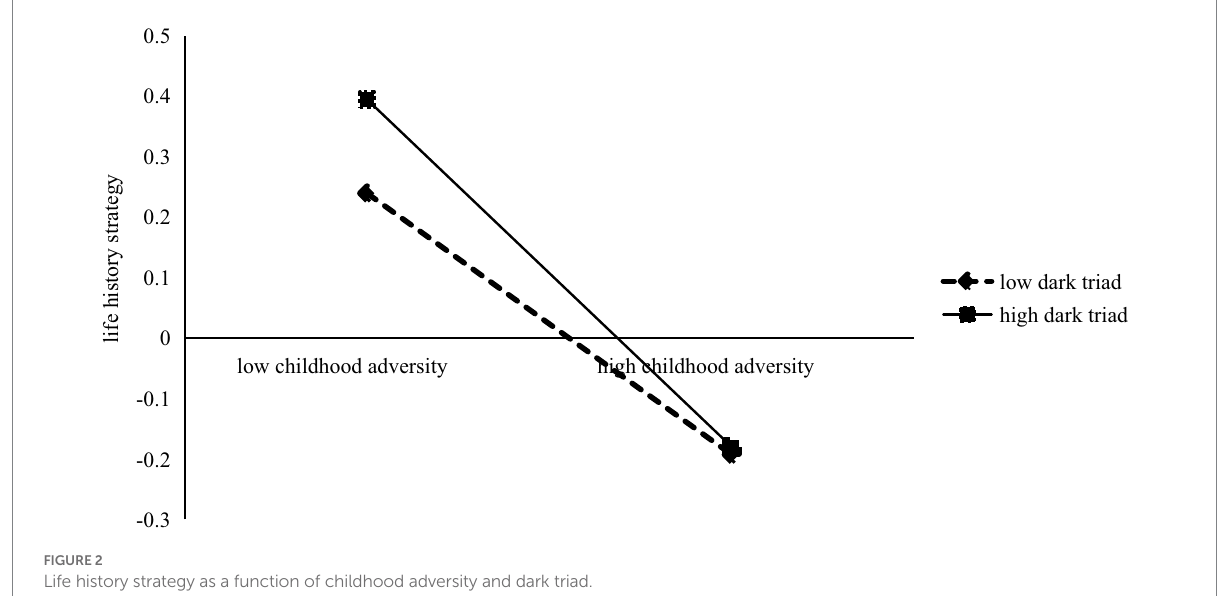
FIGURE 2 Life history strategy as a function of childhood adversity and dark triad.